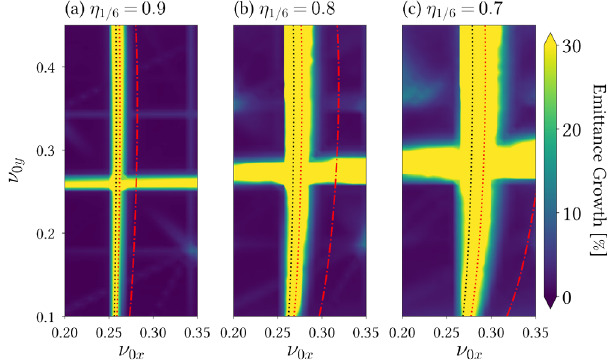
FIG. 5. Beam-intensity dependence of the stop band near ν ¼ 1 = 4 obtained from 2D W ARP simulations. The initial 0 x beam parameters are determined in the same way as in Fig. 4. The same color has been used in the region where the emittance growth exceeds 30%. The tune depressions at the operating point ð ν 0 x ; ν 0 y Þ ¼ ð 1 = 6 ; 1 = 6 Þ are adjusted to (a) η 1 = 6 ¼ 0 . 9 , (b) η 1 = 6 ¼ 0 . 8 , and (c) η 1 = 6 ¼ 0 . 7 . The dotted lines are the theoretical prediction from Eq. (8) for the linear ( m ¼ 2 ) resonances associated with the quadrupole mode (red) and breathing mode (black). The tune-shift factors have been assumed to be C 2 ¼ 0 . 75 for the former mode and C 2 ¼ 0 . 5 for the latter. There seem to be no resonances exactly along those lines. The dash-dotted line in each panel represents Γ 20 ¼ 1 = 2 with the maximum incoherent tune shift of the Gaussian distribution.